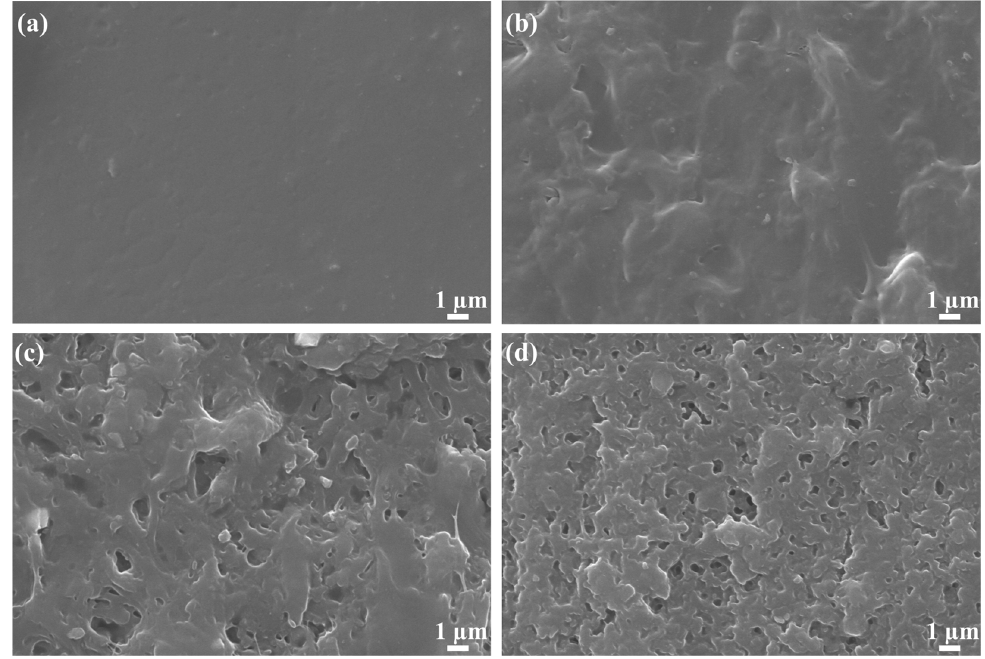
Figure 1. The surface ( a ) and interior ( b ) SEM micrographs of the as-prepared PAM after vacuum- drying; The surface ( c ) and interior ( d ) SEM micrographs of the as-prepared OIM@PAM after vac-